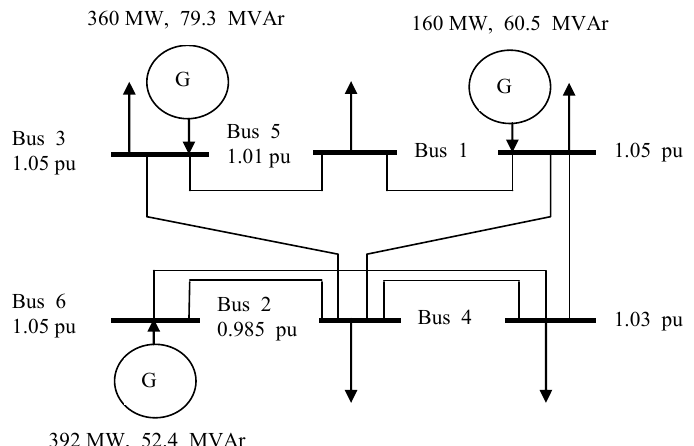
Figure 6. Structure of 6-bus network that resulted from applying the proposed problem in the last year. Table 6. Results of different factors in 6-bus network for LACPF.